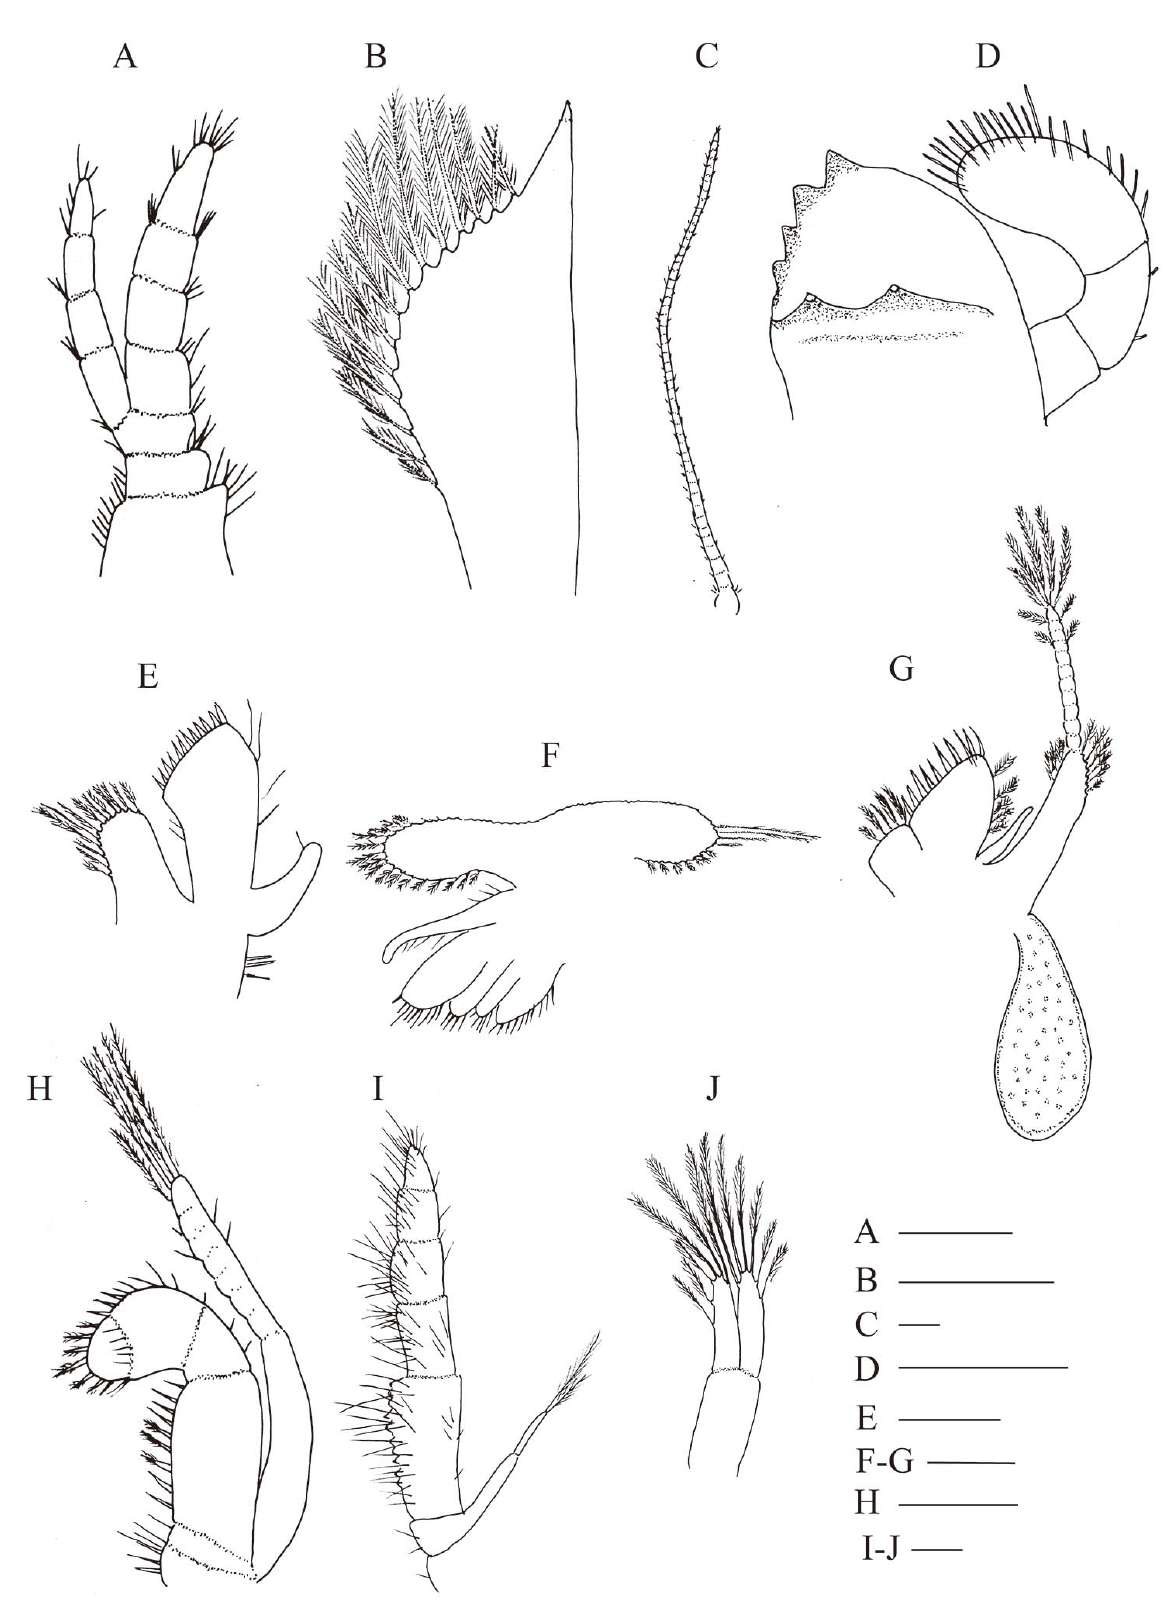
Figure 16. Juvenile Stage II of Cambaroides japonicus . ( A ) Antenna 1, dorsal view; ( B ) antennal scale, dorsal view; ( C ) antenna 2, dorsal view; ( D ) mandible, view of inside of mouth; ( E ) maxilla 1, oral view; ( F ) maxilla 2, oral view; ( G ) first maxilliped, oral view; ( H ) second maxilliped, oral view; ( I ) third maxilliped, oral view; ( J ) pleopod. Scale bars: 0.25